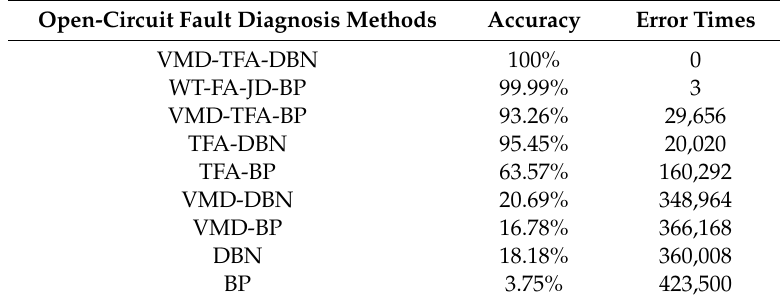
Table 5. The simulation comparison results of open-circuit fault diagnosis under 9